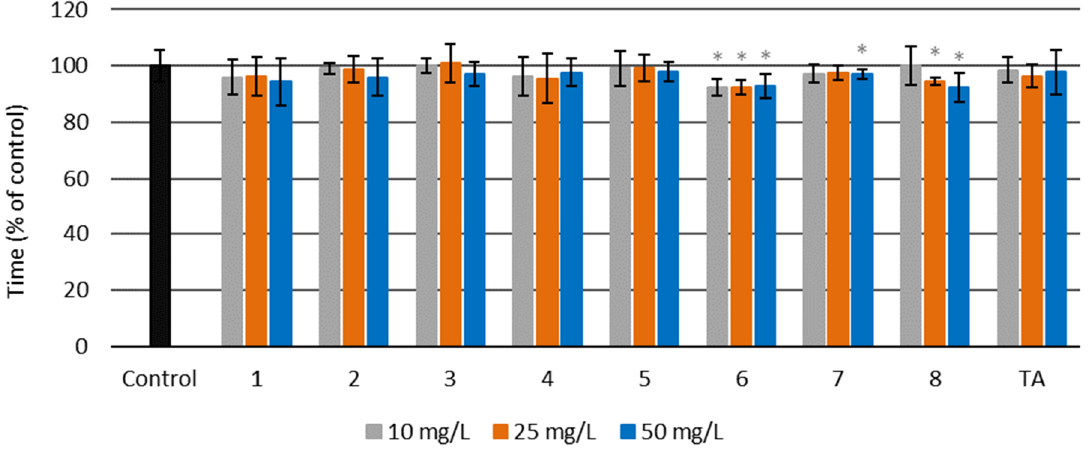
Figure 10. Thrombin time (TT) for amides 1–8 and tranexamic acid (TA) at three different concentrations—10, 25 and 50 mg/L—and for the control sample of human blood plasma (untreated with the examined amides) (* p < 0.05).